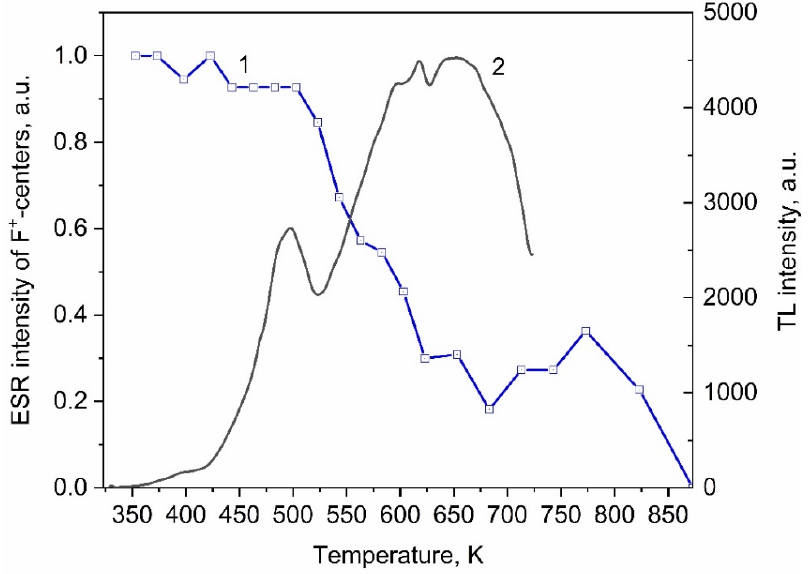
Figure 4. Dependence of the intensity of the ESR signal of F + -centers on the heating temperature (1) and TL (2) of ZrO 2 samples irradiated with xenon ions.